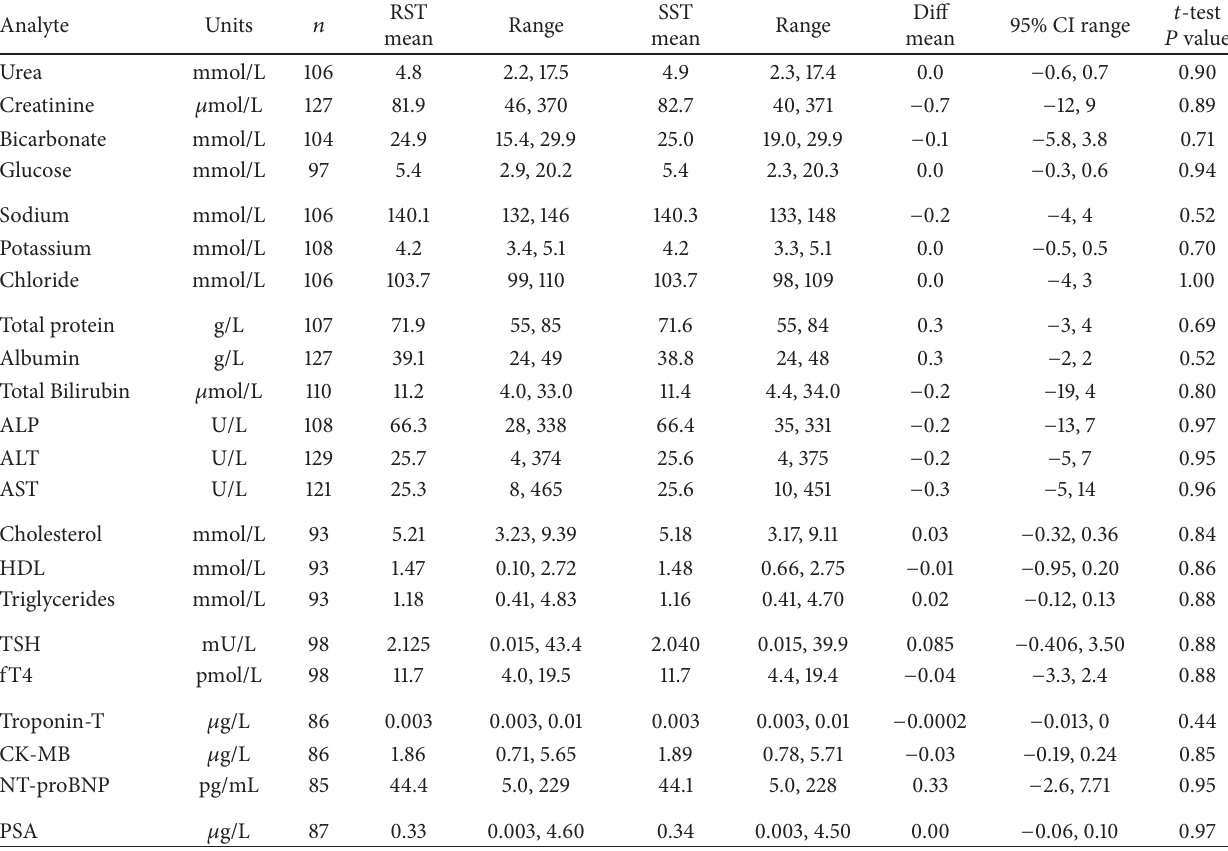
Table 2: Summary statistics for RST results compared with control (SST)